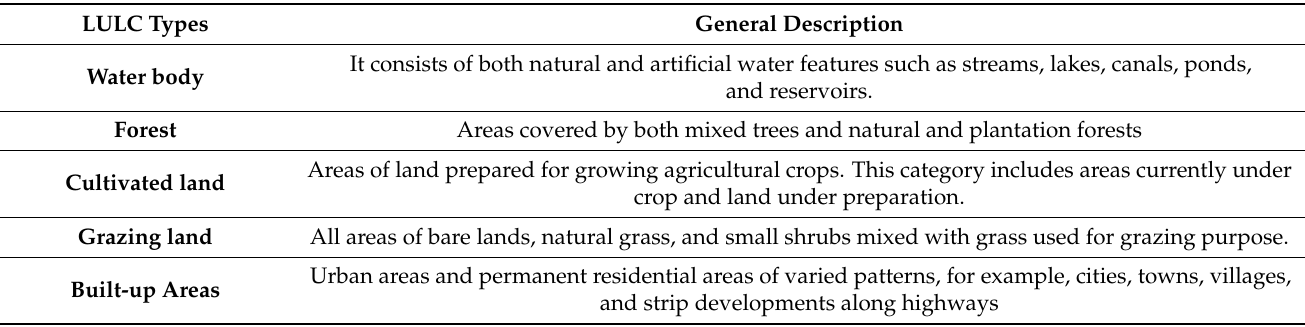
Table 1. Description of land use and land cover types in the study